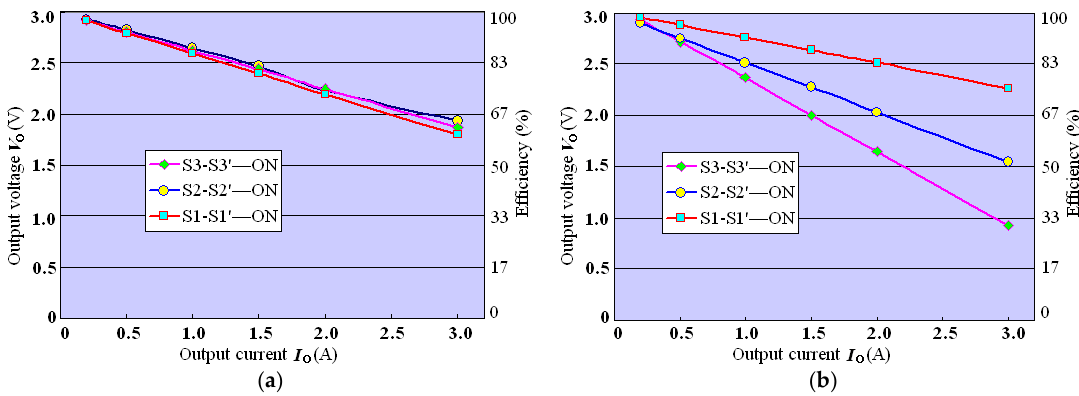
Figure 12. Gate signals and currents waveforms with ON switch S 3 _S 3 ’ : ( a ) waveforms of the proposed equalizer; and ( b ) waveforms of the conventional equalizer.